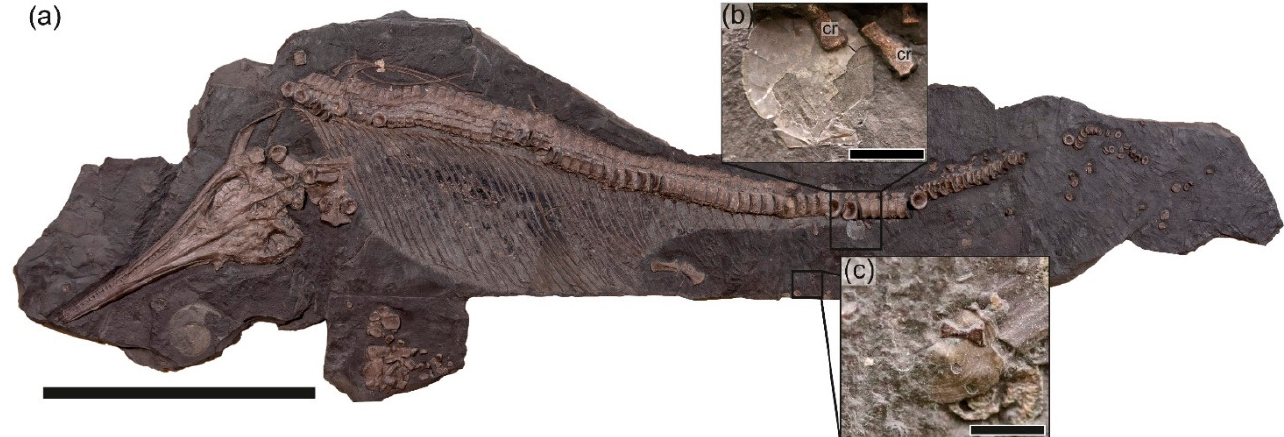
Figure 7. SMNS 80113, Stenopterygius triscissus , prepared from below. ( a ) Photo, copyright M. Wahler/SMNS; ( b ) Eopecten strionatis ; ( c ) Mesomiltha pumila . Abbreviation: cr, caudal ribs. Scale bars = 50 cm ( a ), 20 mm ( b ), 5 mm ( c ).